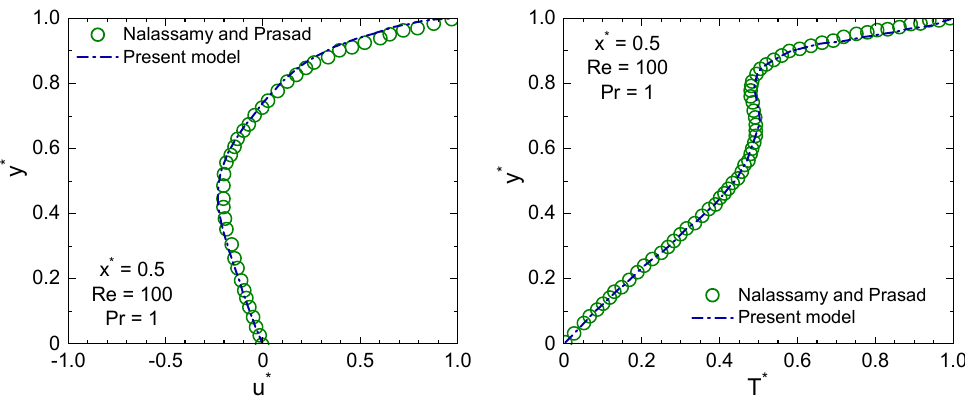
Figure 5. The comparison between dimensionless local velocity ( u *) and temperature ( T *) at the cavity center ( x * = 0.5) along the height of a simplified lid-driven square cavity without the fin with those of Nalassamy and Prasad [56].